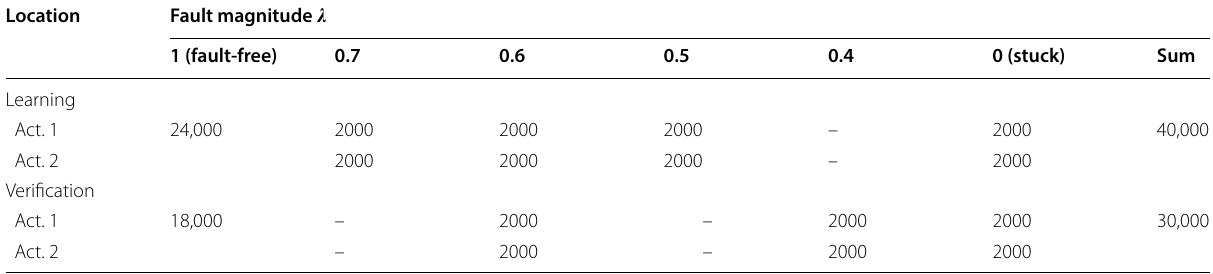
Table 3 Number of samples of experimental data that were used to learn ELM, and to calculate the accuracy rate of the FD results obtained from the constructed FD system